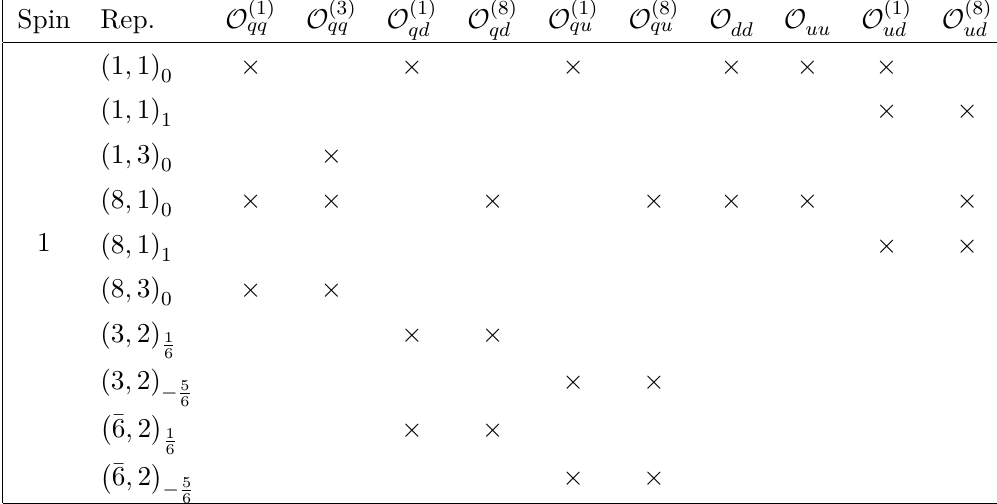
Table 7 . Four-quark ( ψ 4 ) operators generated from additional vector